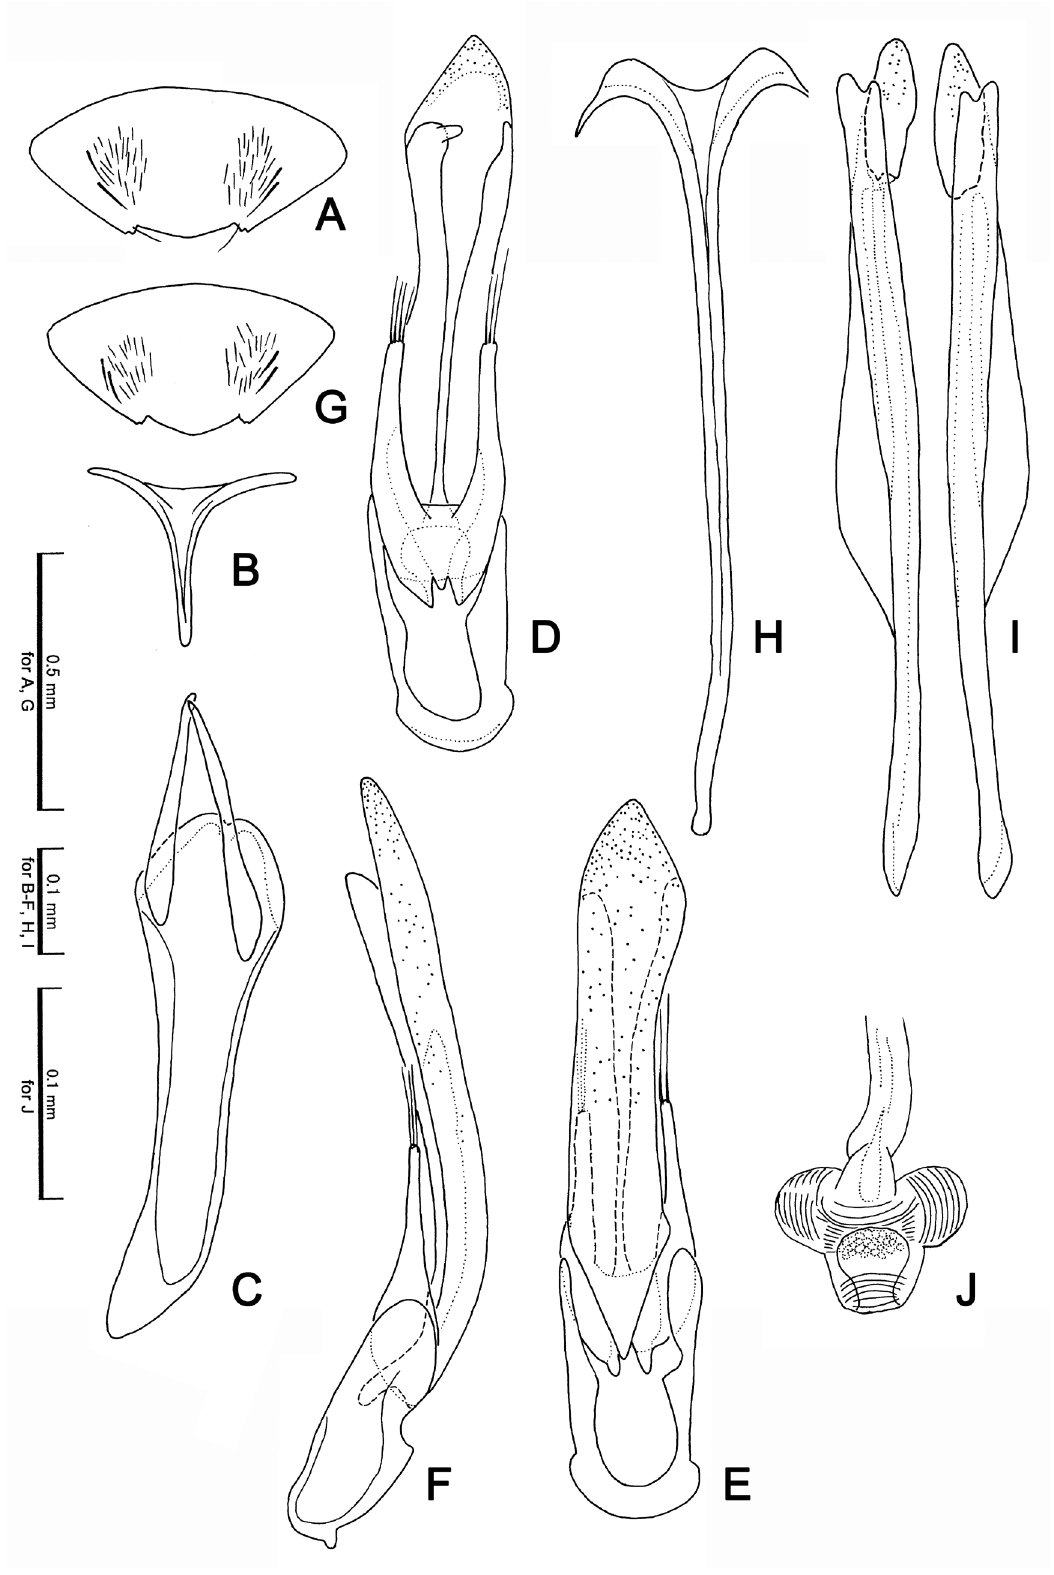
Fig. 17. Mexico taiwanus (Satô, 1994), male (A–F) and female (G–J) genitalia (EUMJ). A, G . Sternite VII. B . Sternite VIII. C . Sternite IX. D . Aedeagus, ventral view. E . Aedeagus in dorsal view. F . Aedeagus in right lateral view. H . Urosternite. I . Ovipositor. J